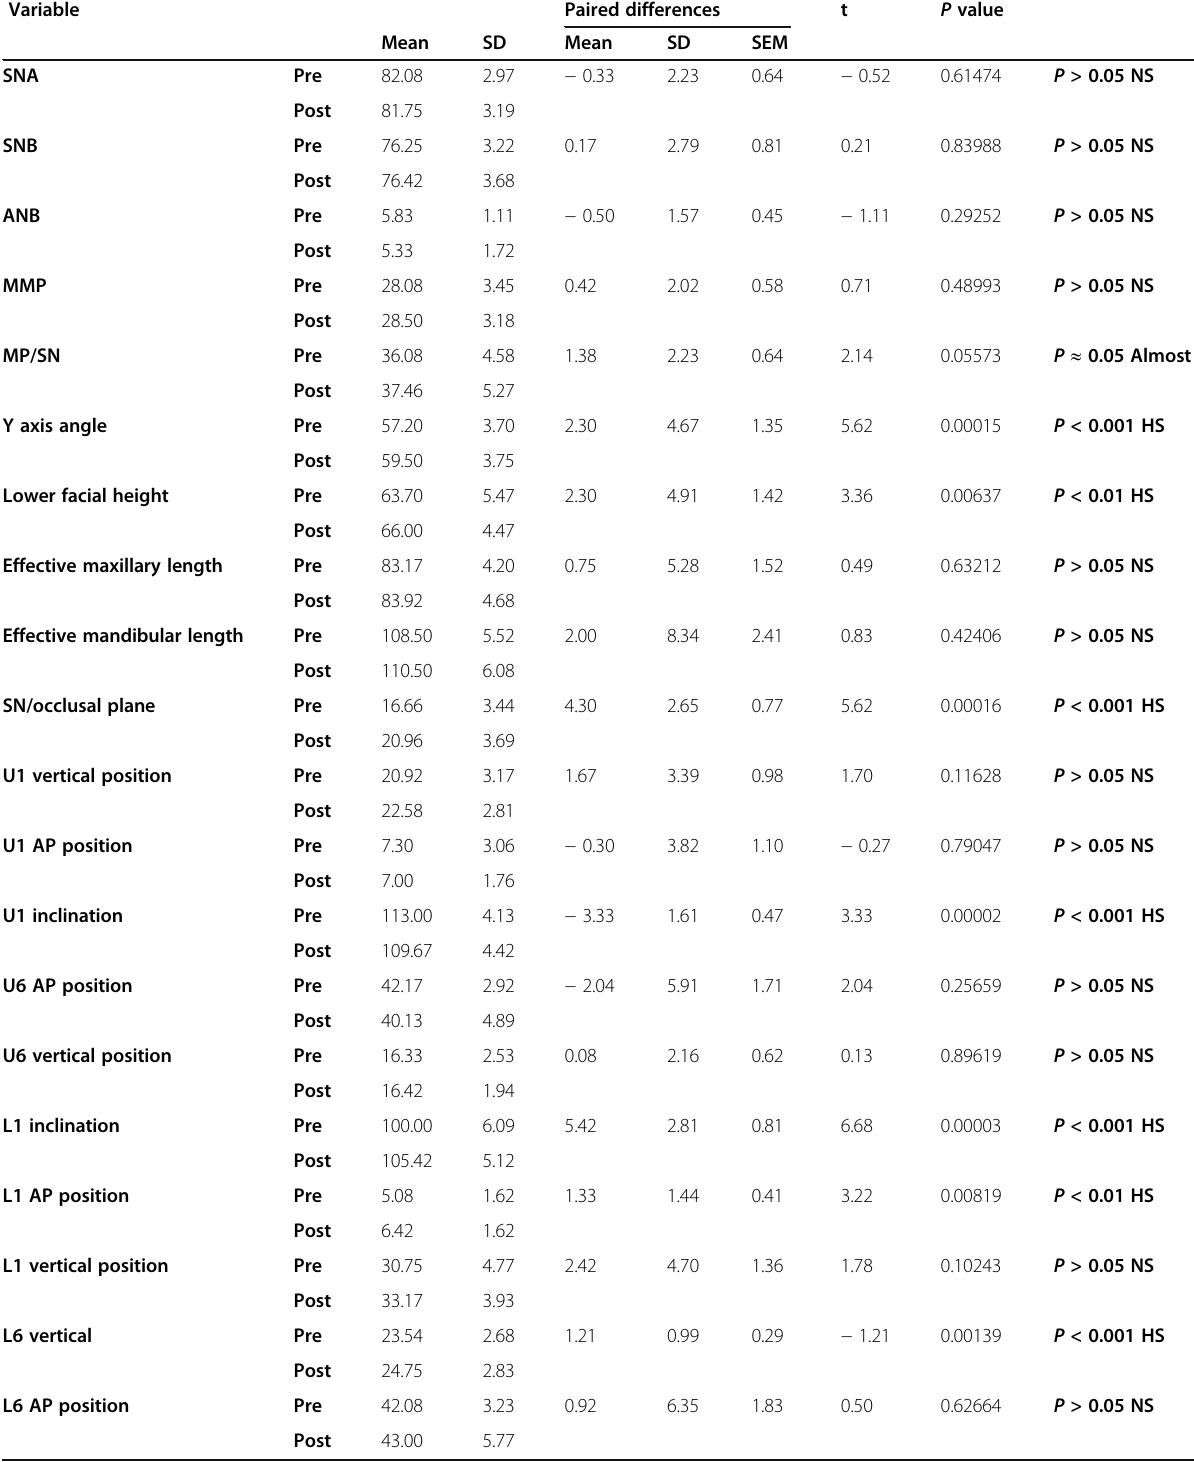
Table 2 Paired t test for comparing the dental and skeletal changes after class II elastics phase for the conventional group Variable Paired